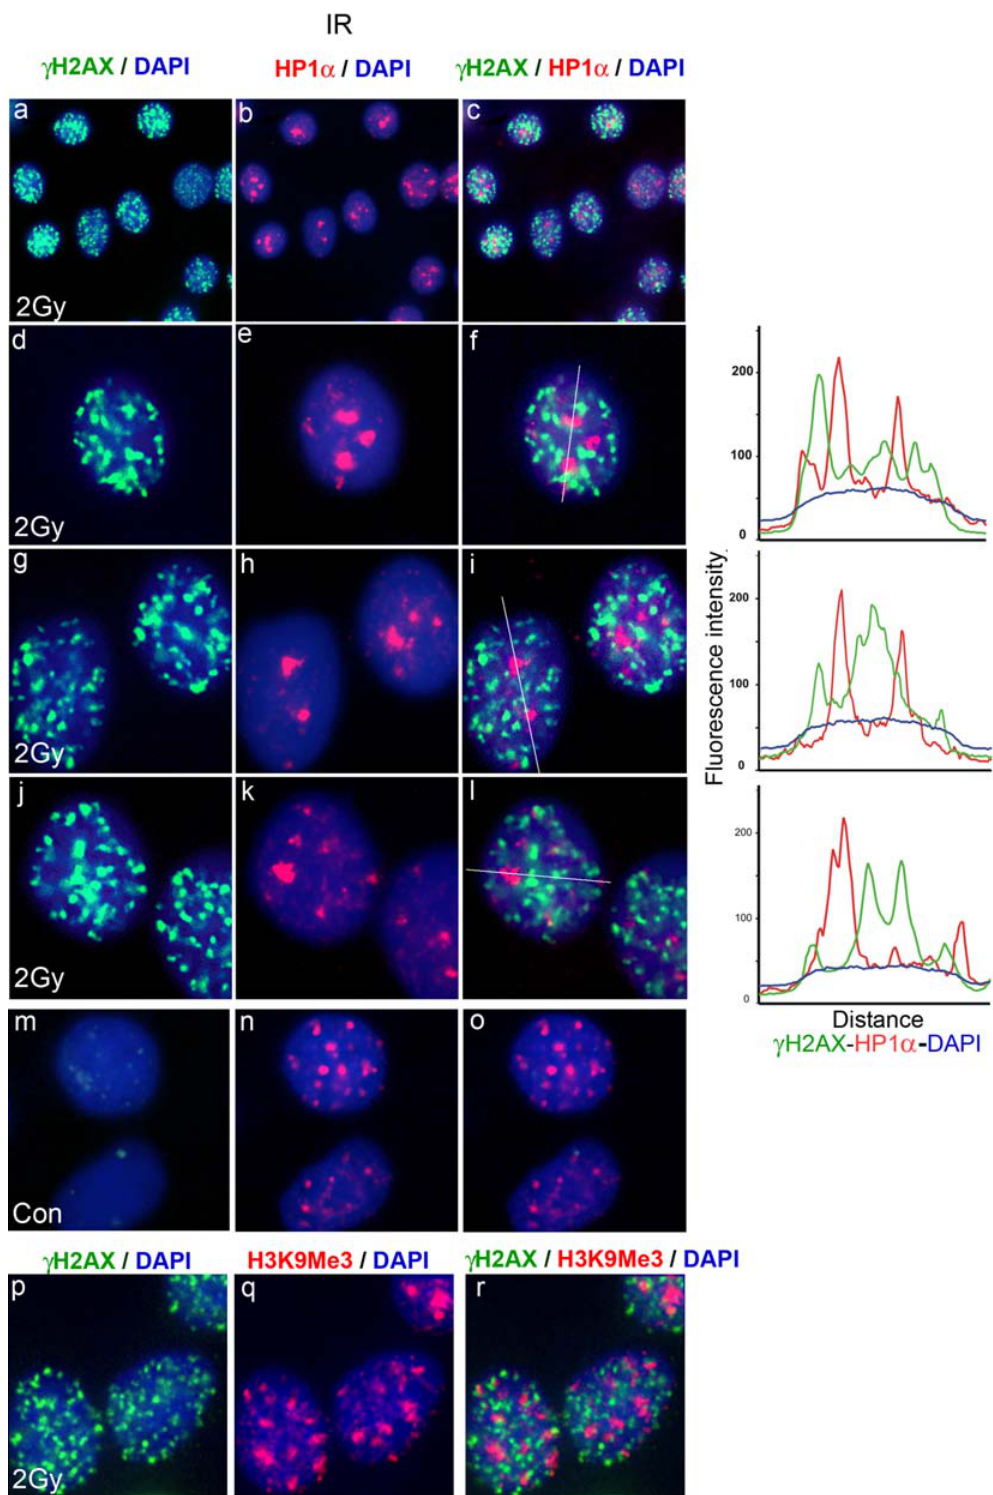
Figure 1. c H2AX foci induced by ionizing radiation are absent from HP1 a -staining nuclear domains. MCF7 cells were fixed 30 minutes after X- irradiation (2Gy, panels a–l & p–r) and were processed for immunofluorescence for c H2AX (green) and either HP1 a or H3K9Me3 (red). Panels m–o, non- irradiated cells. DNA was stained with DAPI. Panels a, d, g, j, m & p, c H2AX; panels b, e, h, k & n, HP1 a ; Panel q, H3K9Me3; panels c, f, I, l, o & r merged images. Overlapping red and green signals appear yellow. The top row shows a group of cells with typical appearance. Individual nuclei are shown magnified in rows 2–6. For the nuclei shown in rows 2–4, line traces were generated (shown on the right) with the line drawn through the brightest HP1 a regions. For c H2AX, HP1 a and H3K9Me3, images were first adjusted using levels such that fainter interfocal nuclear fluorescence was not included.